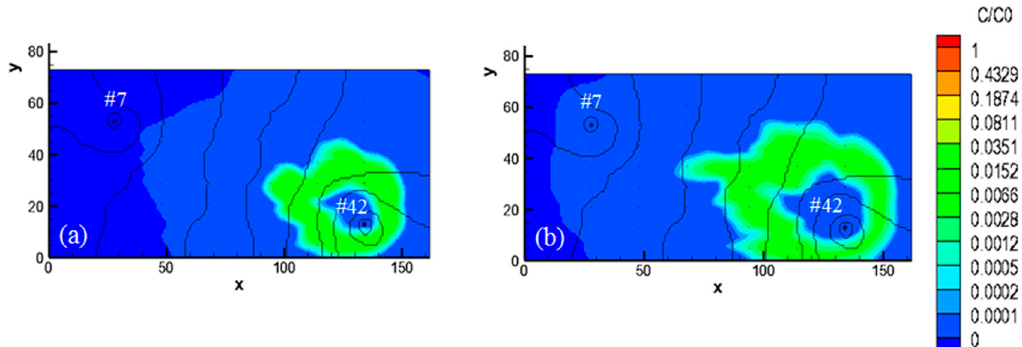
Figure 8. Concentration distribution of the estimated field at specific time point: ( a ) at 1000 s; ( b ) at 2000 s. The black line represents the water table contour; the light blue area represents the concentration range during solute transport; the outer boundary line is the forefront of solute transport; the round spot in the upper left corner represents the pumping well #7, and the round spot in the lower right corner represents the injection well #42. The units of axis are cm.